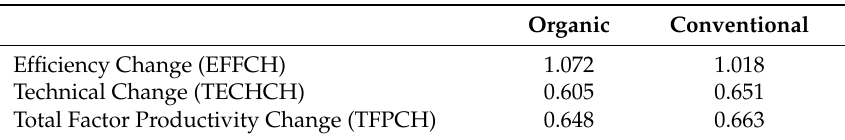
Table 1. Productivity